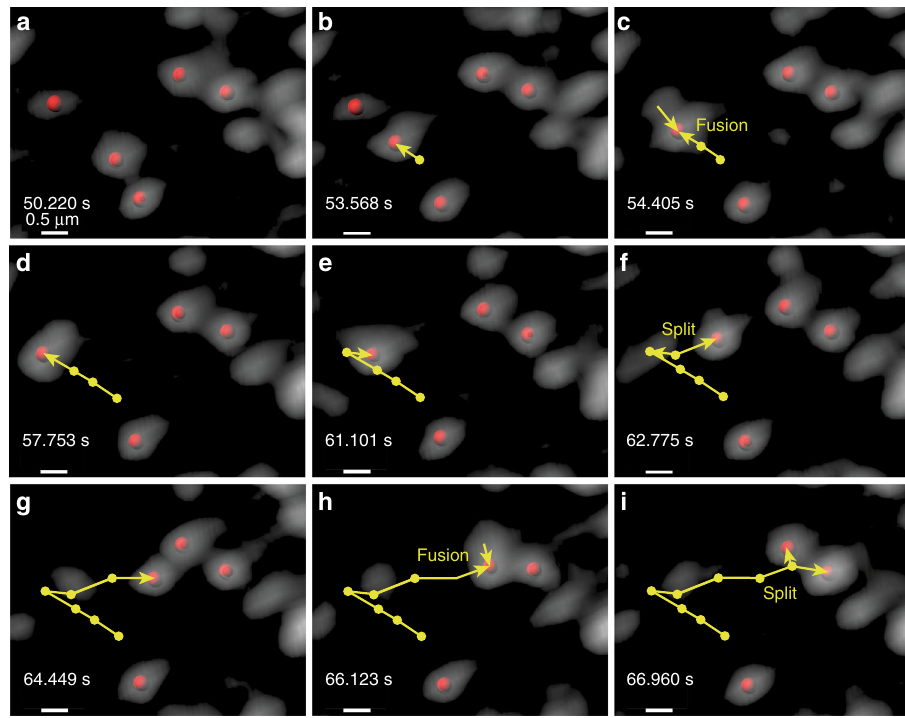
Fig. 2 Intracellular colocalization and splitting events for GFP-Rab11A foci. Multiple instances of merging and splitting GFP-Rab11A foci (shown here in gray) can be identi fi ed in live-imaging datasets. a – i Chronologically ordered time snapshots follow a moving GFP-Rab11A spot merging with and splitting from other GFP-Rab11A foci. The yellow track shows location history and current direction of motion. For clarity, only centers of those GFP-Rab11A foci that take part in this interaction are denoted by red spots. The surrounding vesicles are either stalled or very slow moving. Timestamps show time elapsed since the start of the dataset. Scale bars are 0.5 μ m as